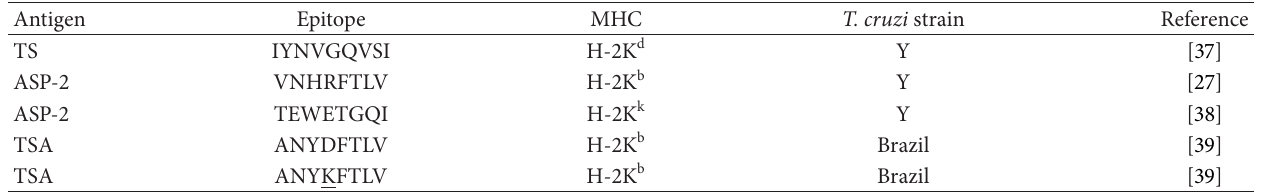
Table 1: Immunodominant epitopes recognized by murine CD8 + lymphocytes after infection with T. cruzi .